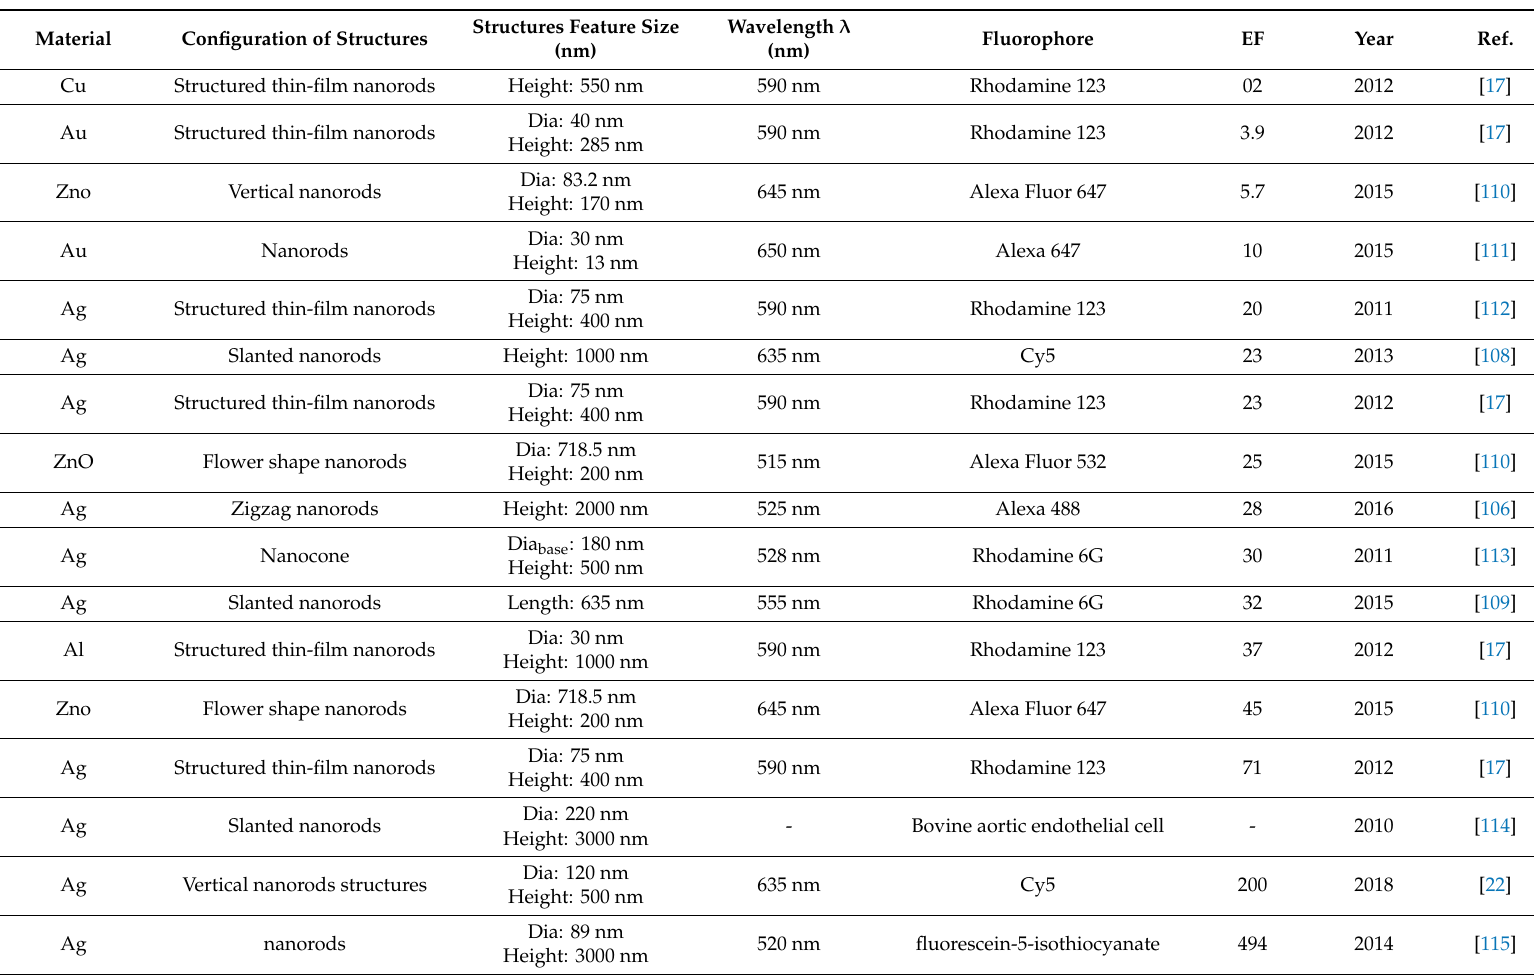
Table 3. Summary of various nanostructures fabricated via various deposition methods with di ff erent shapes and geometries, and their experimentally determined enhancement factor (EF), with feature size, excitation wavelengths, used fluorophores, and publication information such as year and reference, for further